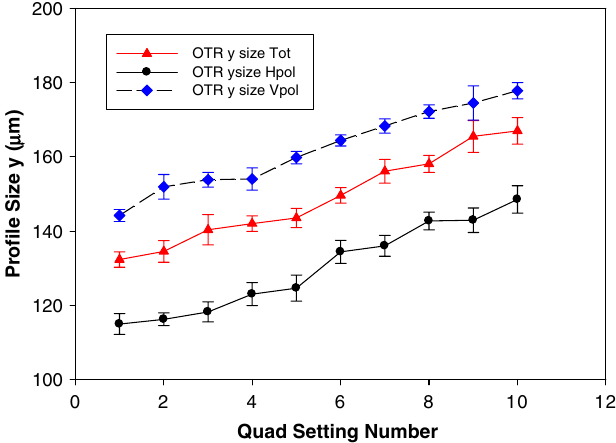
FIG. 12. Comparison of the projected OTR x profiles using no polarizer (black) and the vertical polarizer (red). The perpen- dicular component’s width is (cid:1) 15% smaller than the total OTR case. The beam sizes are from the ten-image sum as given in Table